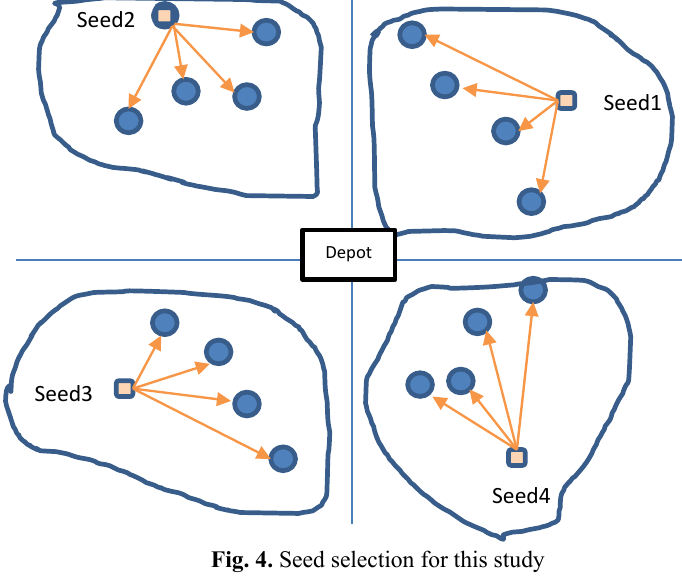
Fig. 4. Seed selection for this